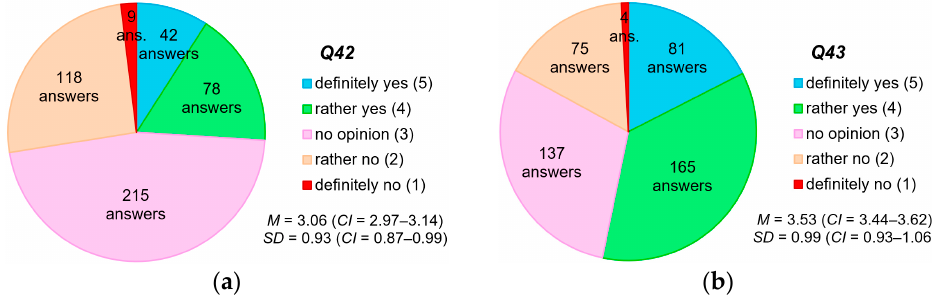
Figure 15. Assessment of interest in the use of shower heat exchangers ( M —average, SD —standard deviation, CI —confidence interval; questions numbers (Q) according to the Appendix A): ( a ) question Q 42; ( b ) question Q 43.